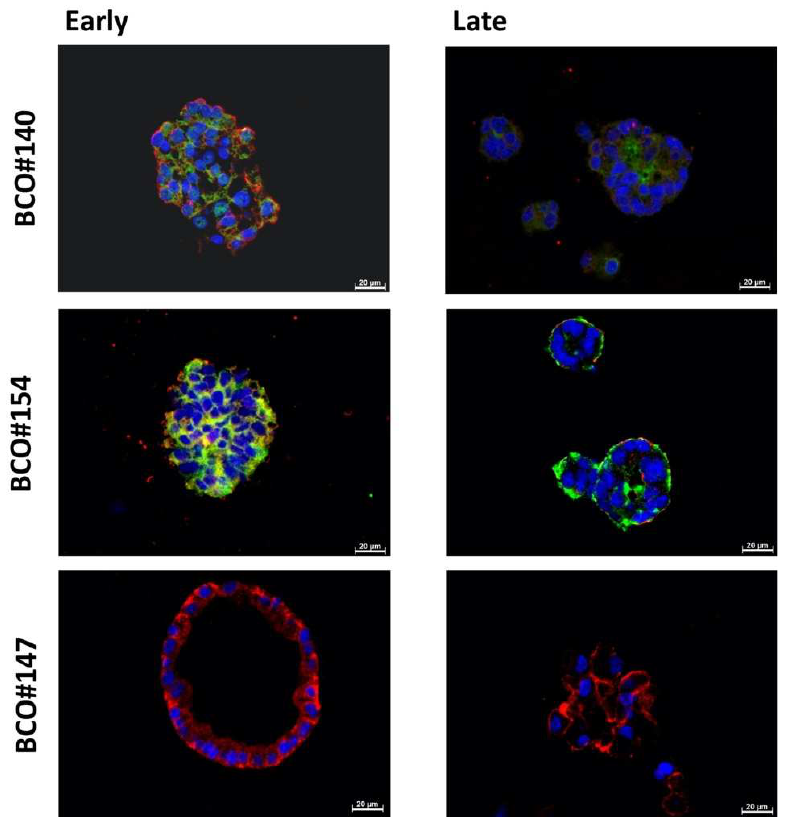
Figure 8. Detection of CD24 and CD44 on paraffin section of organoids. Paraffin sections of BCO#140, #154, and #147 were generated and stained with primary antibodies reactive with bladder cancer stem-cell markers CD24 and CD44. Expression of CD24 was visualized by a green fluorescent AlexaFluor488-labelled detection antibody. CD44 was visualized by a red fluorescent Cy3-labelled detection antibody. Cell nuclei were stained by DAPI.